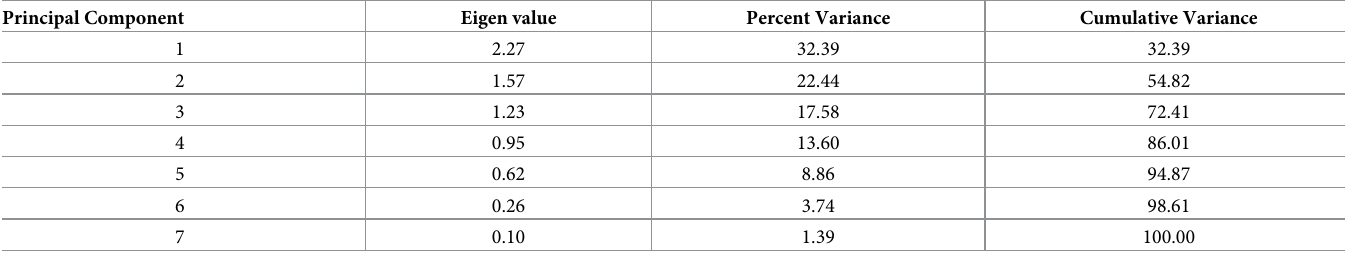
Table 1. Principal components and eigenvalues. Principal